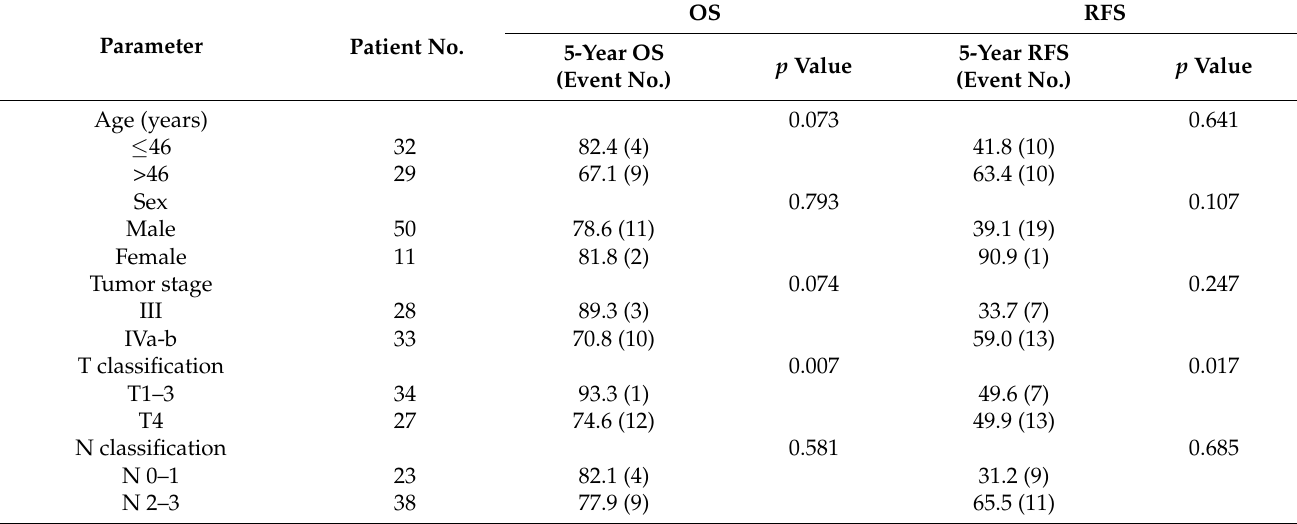
Table 2. Univariate analysis of clinical factors and PET or MRI imaging biomarkers in relation to overall survival and recurrence-free survival in primary advanced NPC